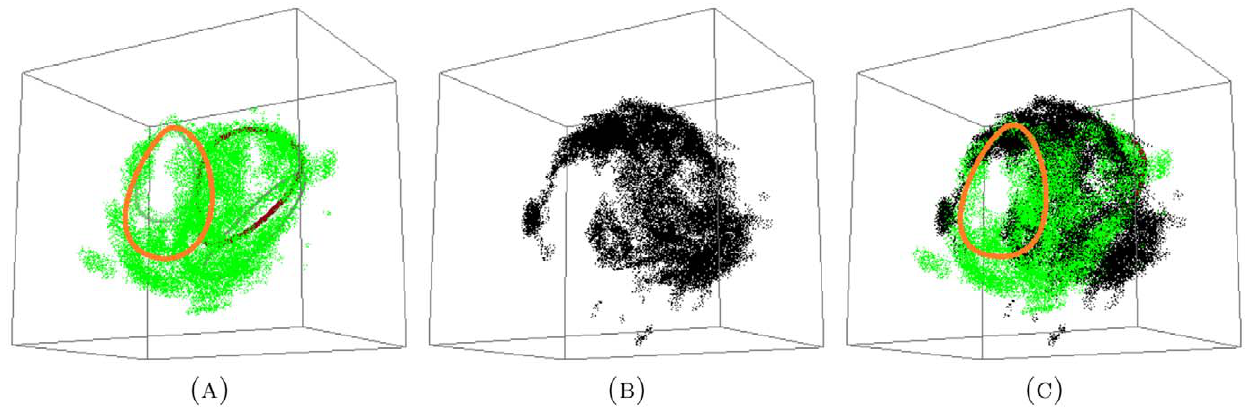
Figure 9. The GMM data for (A) long proximal; (B) distal(max); and (C) the combined long + distal(max) set. There are four persistent generators for the GMM long proximal set, two of which are consistent between the GMM long and GMM long + distal sets (orange and crimson). Grey generators in the GMM long proximal set are not persistent in the combined set. doi:10.1371/journal.pone.0037278.g009 PLoS ONE |